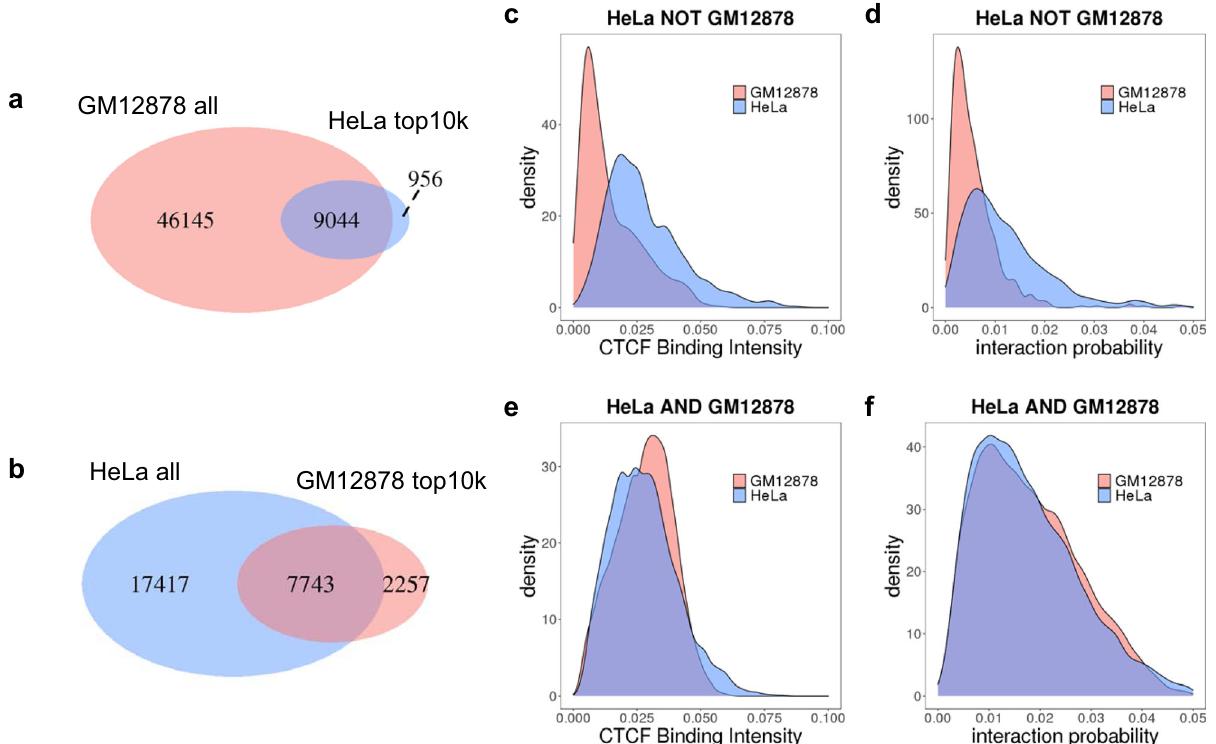
Fig. 9 CTCF-binding intensity is predictive of cell type-speci fi c loops. a , b Venn diagram of CTCF-mediated loops identi fi ed from GM12878 and HeLa ChIA-PET. Only the strongest 10,000 loops are compared against each other due to different sequencing depth. c – f CTCF-binding intensity distribution and predicted interaction probability distribution for HeLa-speci fi c CTCF loops and shared